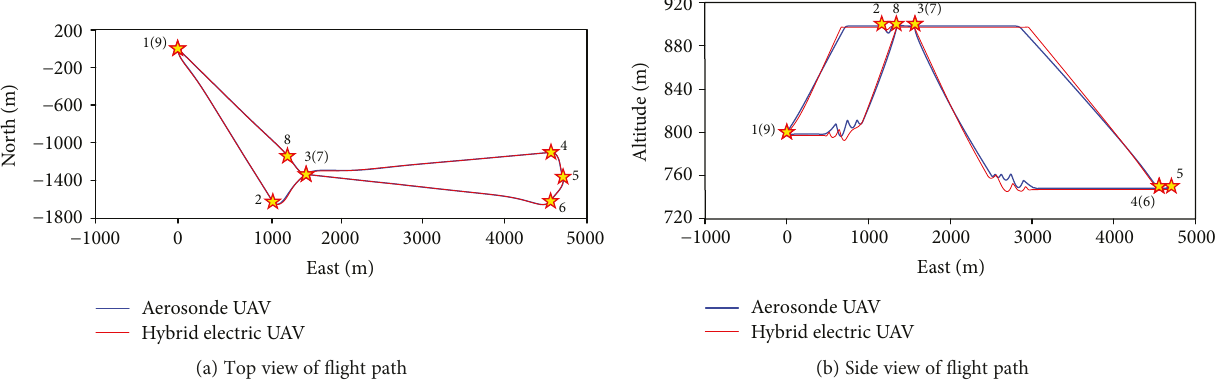
Figure 8: Comparison of the fl ight path.